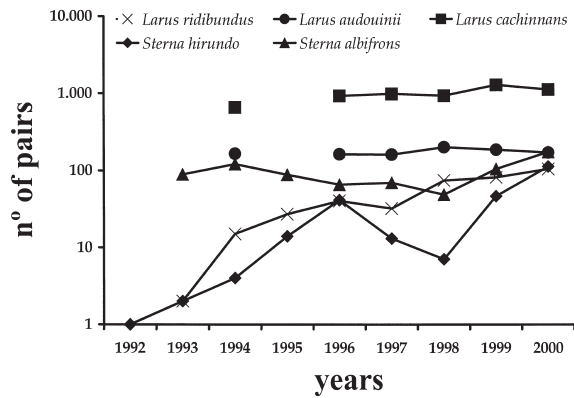
F IG . 2. – Changes in breeding seabird population numbers in the province of Almería (southern Spain). Data only for those species with ample information available for the period